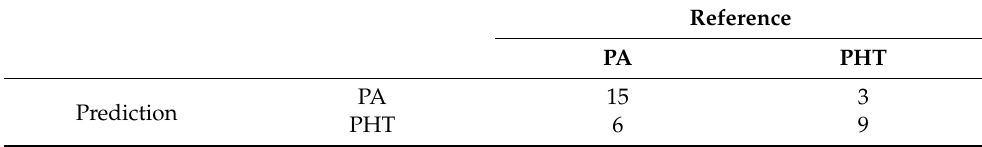
Table A7. Confusion matrix showing the actual and predicted labels for PA vs. PHT.